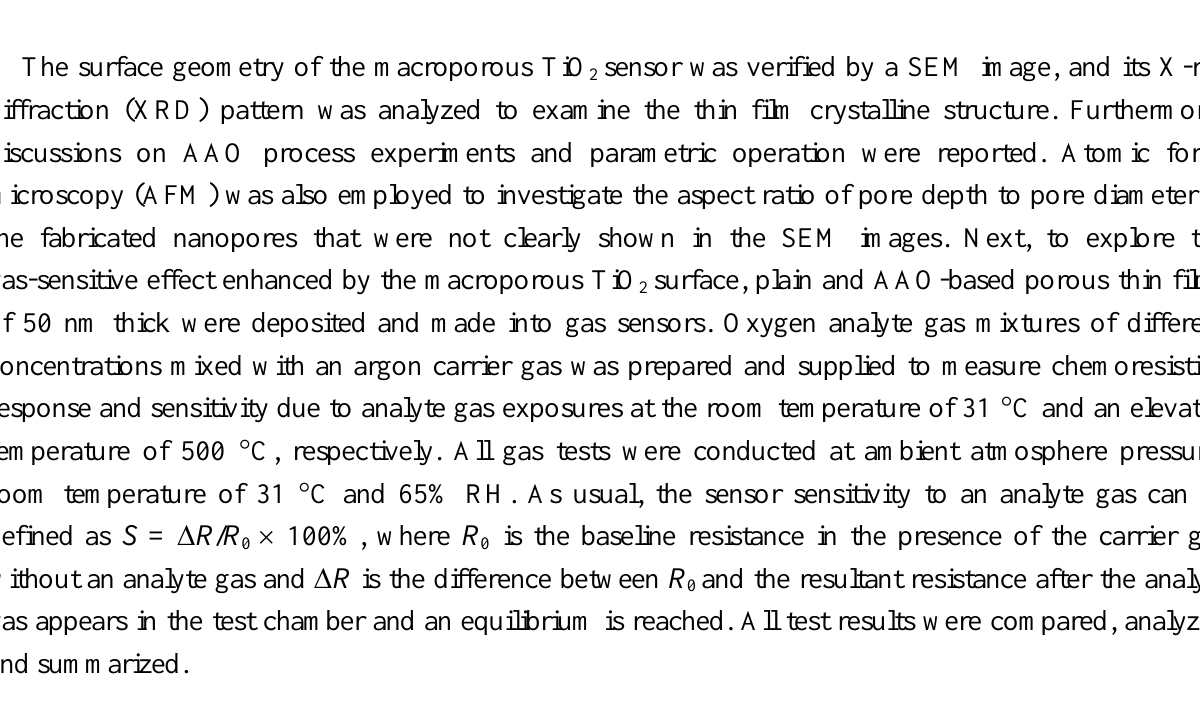
Figure 6. SEM image of the macroporous TiO